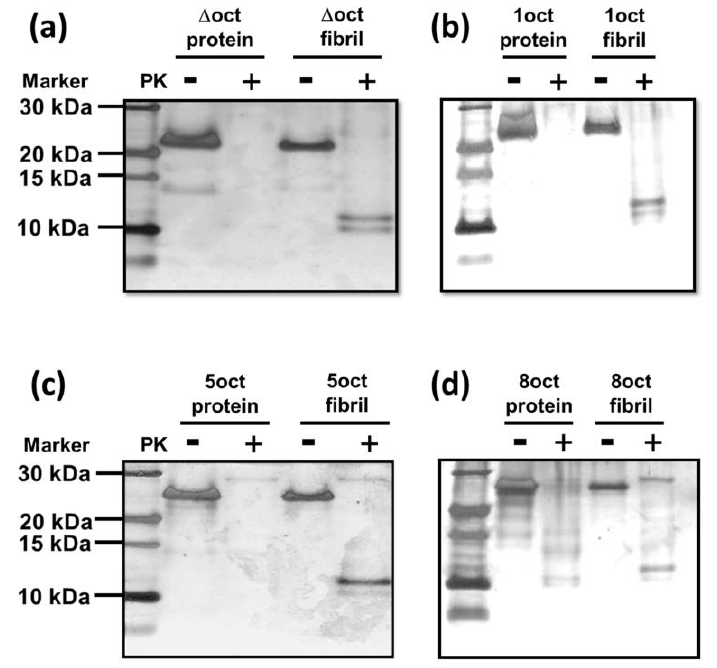
Figure 6. PK-cleavage (PK: PrP = 1:50) of PrP variants ( a ) PrP- ∆ oct, ( b ) PrP-1oct, ( c ) PrP-5oct and ( d ) PrP-8oct in their protein and fibril forms analyzed with tricine-sodium dodecyl sulfate-polyacrylamide gel electrophoresis (SDS-PAGE).